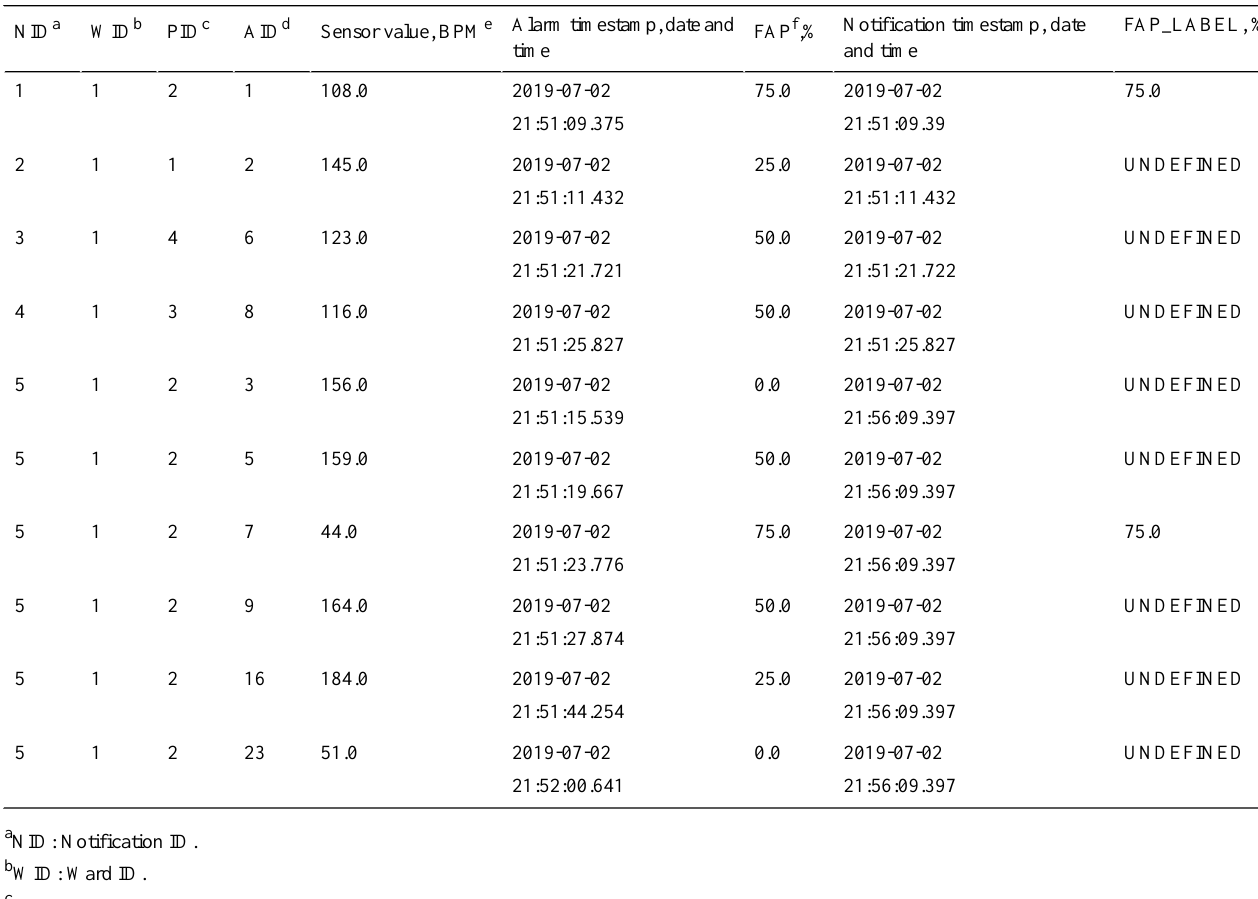
Table 5. Results of our experiments for notifications related to heart rate vital signs.